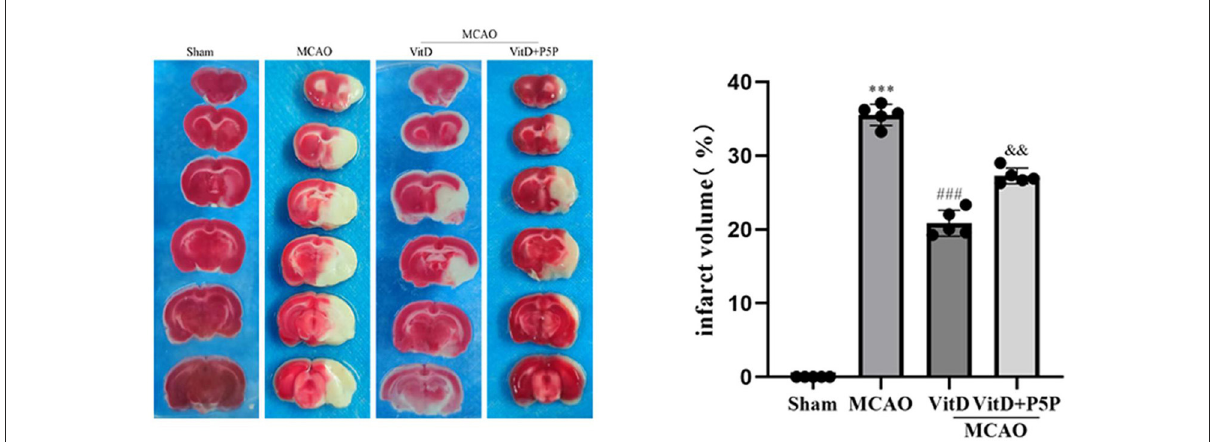
FIGURE1 1,25-D3 reduced the volume of infarct regions in rats 3 days after stroke. All values are the mean ± SEM, *** P < 0.001 (vs. Sham), ### P < 0.001 (vs. MCAO), and && P < 0.01, (vs. VitD), n = 5. P5P, antagonist of VDR; Vit D,